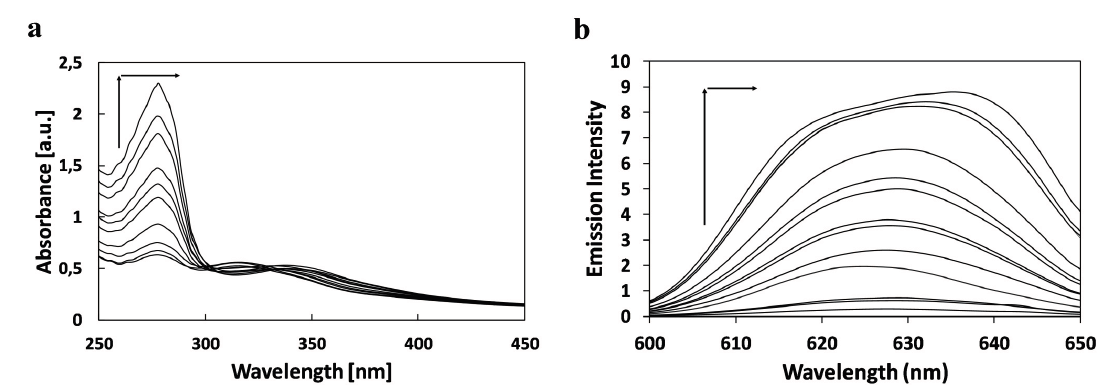
Figure 1. Effect of increasing concentration of BSA on the absorption ( a ) ([BSA] = 0, 2, 3, 7, 13, 16, 20, 27, 30, 40 µM) and fluorescence emission ( b ) ([BSA] = 0, 2, 3, 7, 13, 16, 20, 27, 30, 40, 80, 100, 140 µM) spectra of SQ6 ([SQ6] = 150